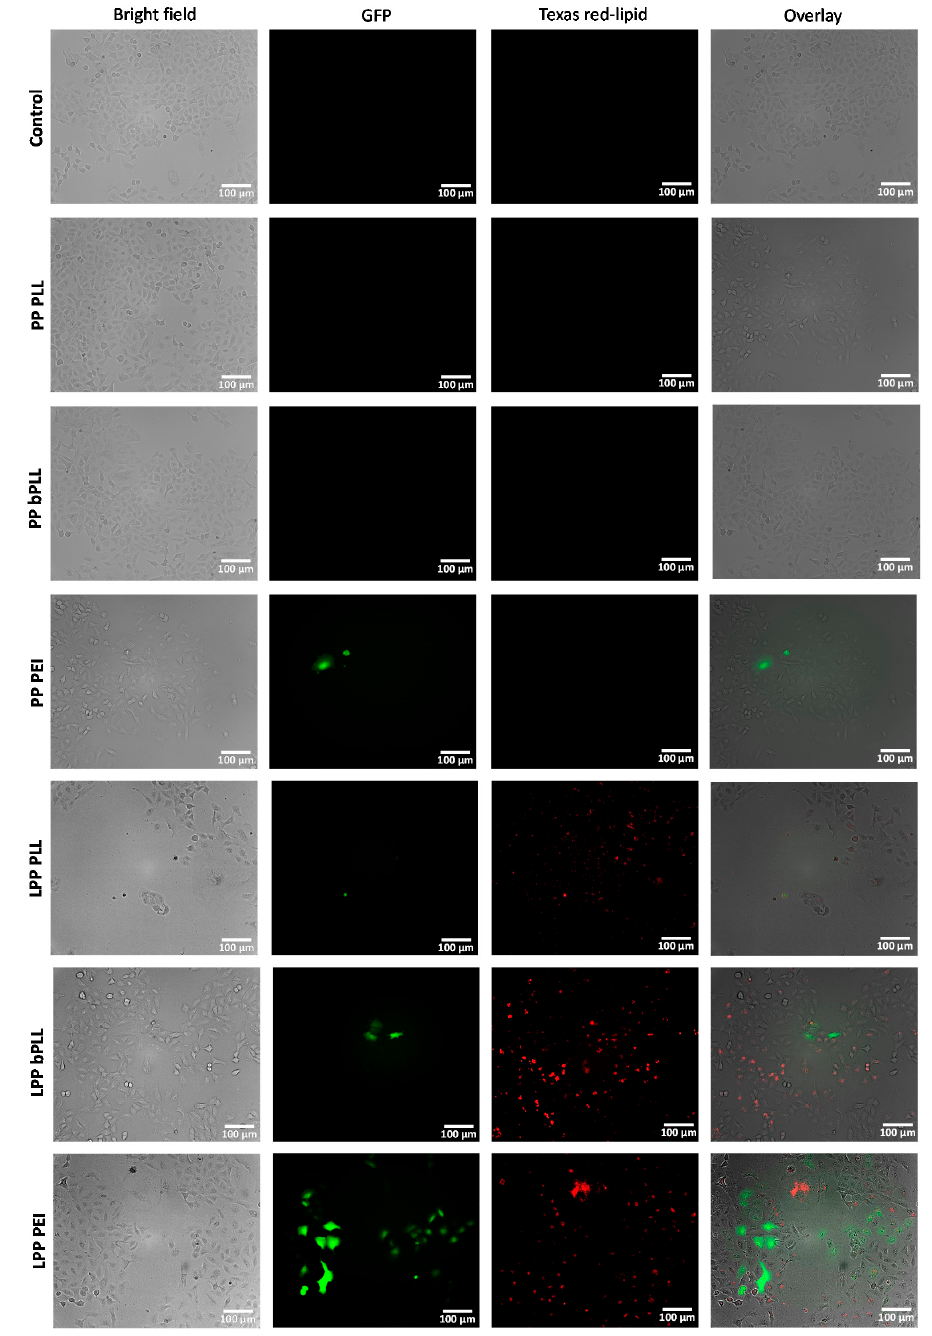
Figure 2. Fluorescence microscopy images of A549 cells in 2D monolayer cell culture 3 d after incubation with polyplexes (PP) and lipopolyplexes (LPPs). The figure shows, from left to right, for each treatment: bright-field image, green fluorescent protein (GFP) fluorescence (green), Texas Red lipid fluorescence (red) and overlay of the three previous images. These results were further confirmed by quantitative analysis of cell fluorescence performed by flow cytometry (Figure 3A). The measured percentage of transfected cells with LPP PEI (ca. 8%) was